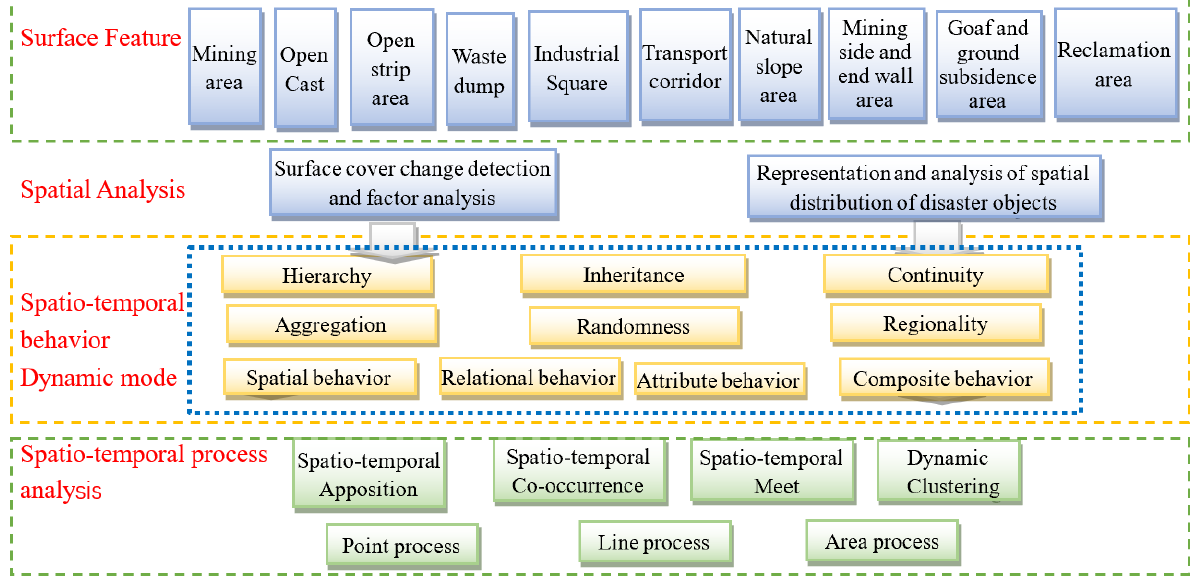
Fig. 2 Analysis of temporal and spatial process of surface